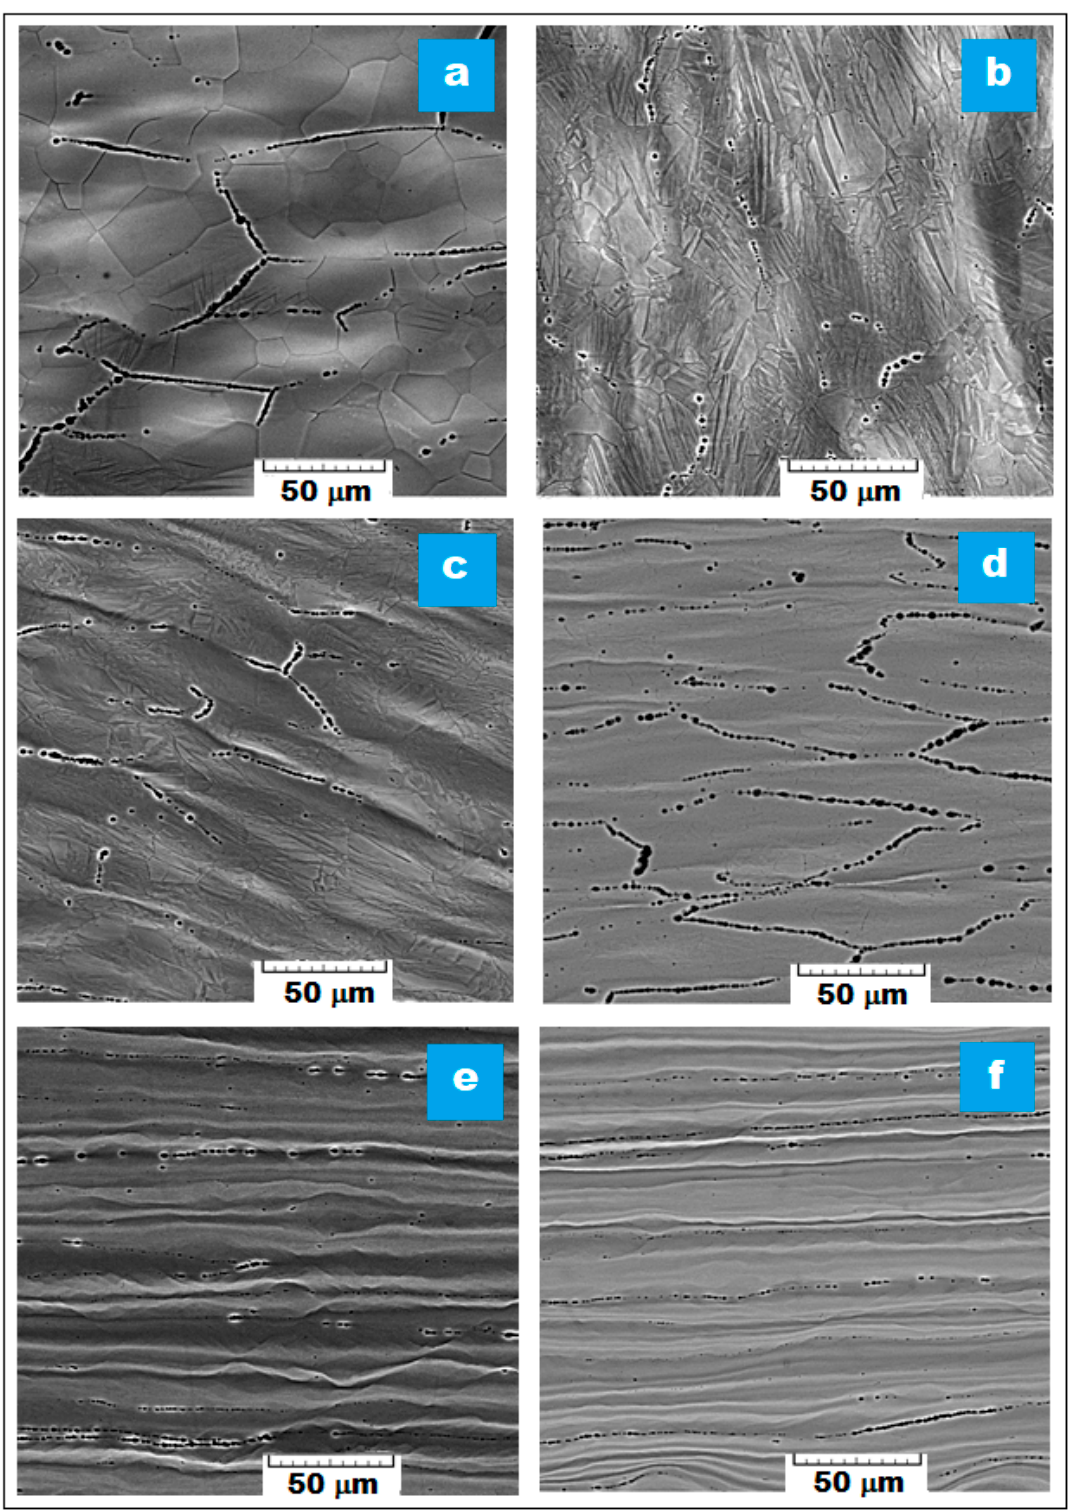
Figure 4. SEM images of the Ti29Nb-9Ta-10Zr alloy corresponding to the following stages: ( a ) initial state—S-1; ( b ) MPR processed with ε = 20%; ( c ) MPR processed with ε = 40%; ( d ) MPR processed with ε = 60%; ( e ) MPR processed with ε = 80%; ( f ) MPR processed with ε = 90%.